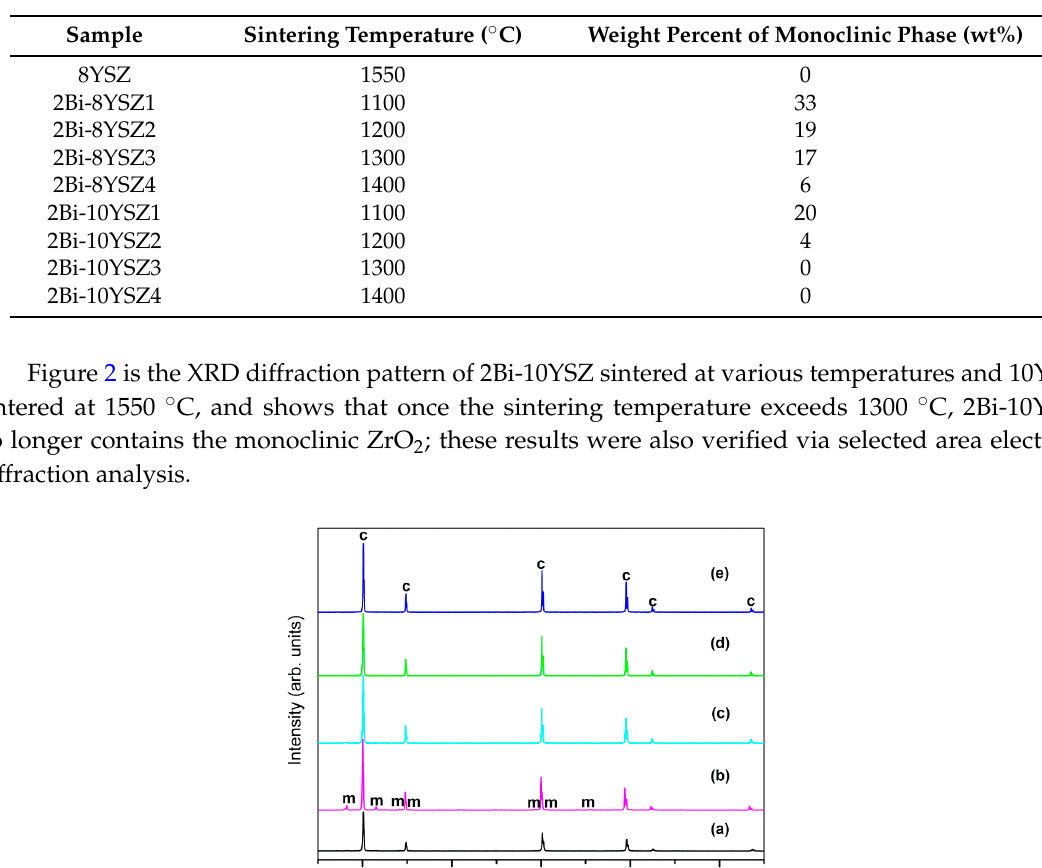
Figure 2. XRD pattern: ( a ) 10YSZ 1550 °C; ( b ) 2Bi-10YSZ 1100 °C; ( c ) 2Bi-10YSZ 1200 °C; ( d ) 2Bi-10YSZ 1300 °C; ( e ) 2Bi-10YSZ 1400 °C.